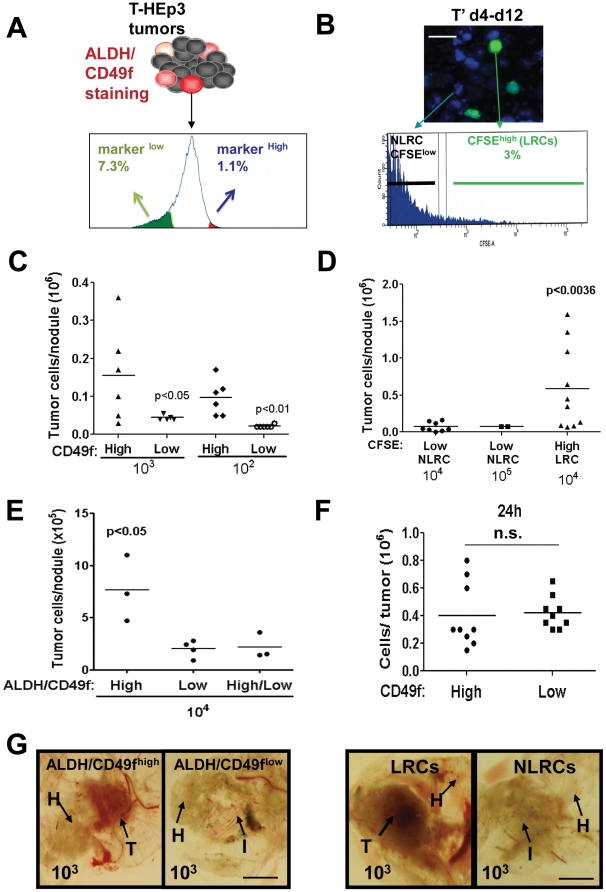
ALDHhigh, CD49fhigh, LRCs proliferative capacity in vivo.(A) Sorting strategy for HEp3 cells with high or low levels of ALDH, CD49f, or both. (B) Sorting strategy for HEp3 tumors labeled with CFSE. (C–E) Quantification of tumor growth after 1 week in vivo on CAM. Dots represent the number of tumor cells per nodule. CD49fhigh vs. CD49flow cells (C), LRC vs. NLRCs (D), and (E) ALDHhigh/CD49fhigh vs. ALDHlow/CD49flow. (F) Quantification of tumor growth after 24 h in vivo on CAM. Dots represent the number of tumor cells per nodule. (G) Representative images of tumor nodules produced by ALDHhigh/CD49fhigh and ALDHlow/CD49flow (left panel) or LRCs and NLRCs (right panel). T = tumor, H = host tissue (CAM), I = inoculation site. Scale bar: 8 mm. p-values estimated using one-way ANOVA followed by the Bonferroni correction with two-tailed P values<0.05 considered significant.